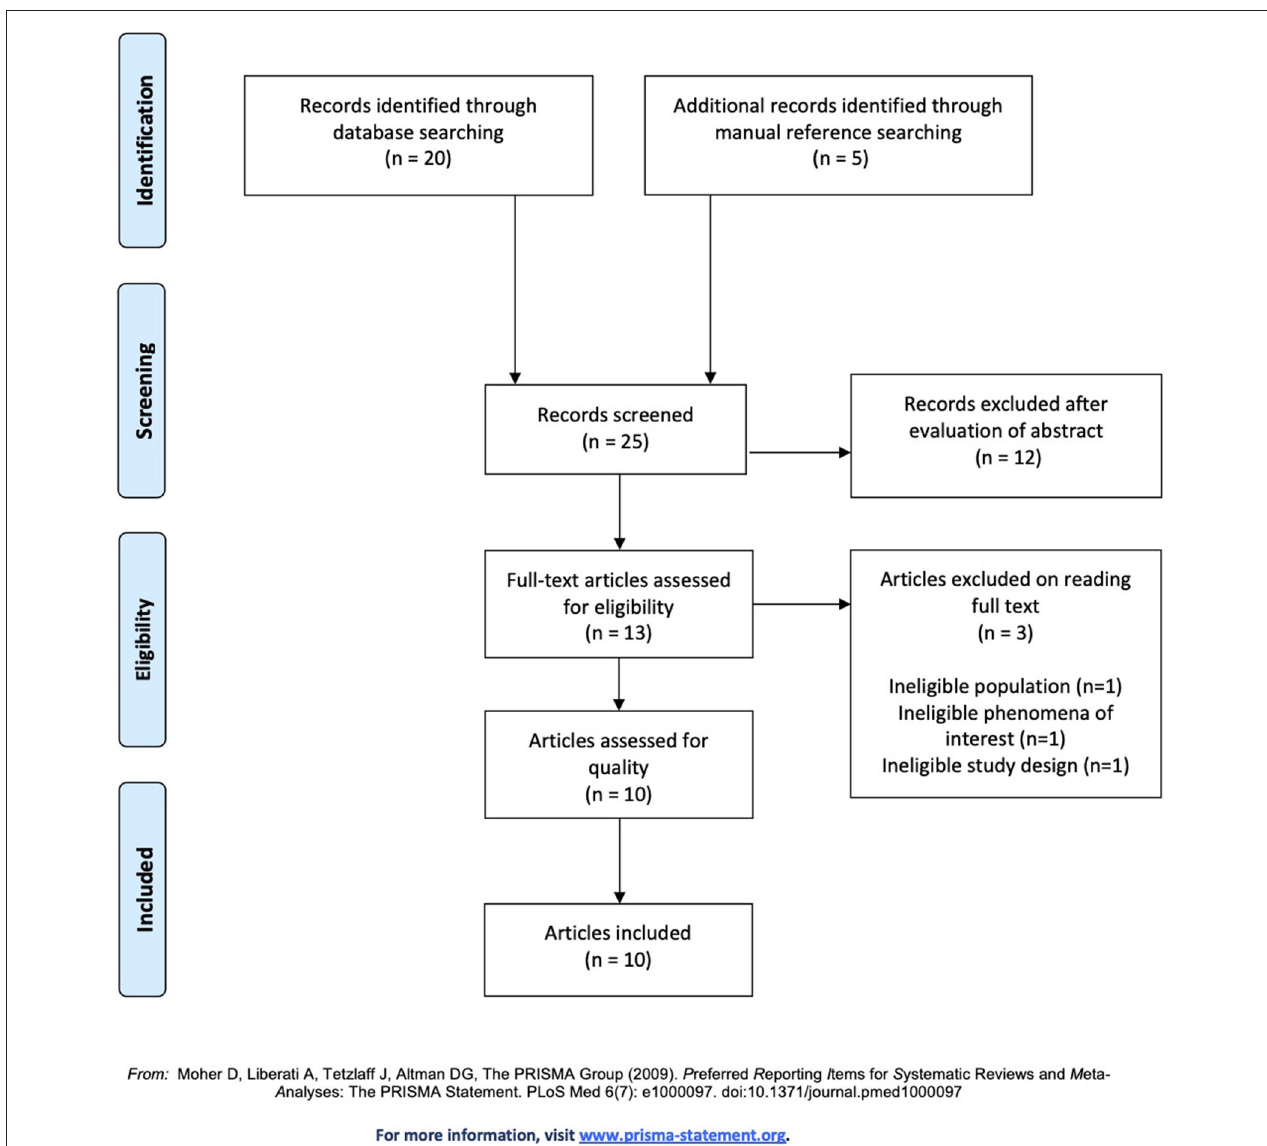
FIGURE 1 | PRISMA flow diagram